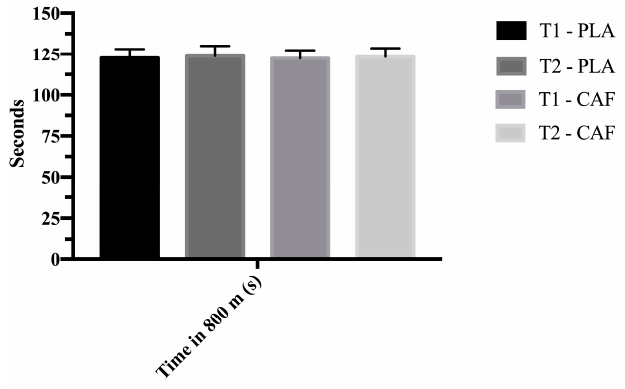
Figure 1. Time in 800 m (s). T1: First test 1; T2: second test; PLA: Placebo; CAF: Caffeine. Table 1. Results of 800-m running time trial test variables. Placebo Caffeine ANOVA Test 1 Test 2 Test 1 Test 2